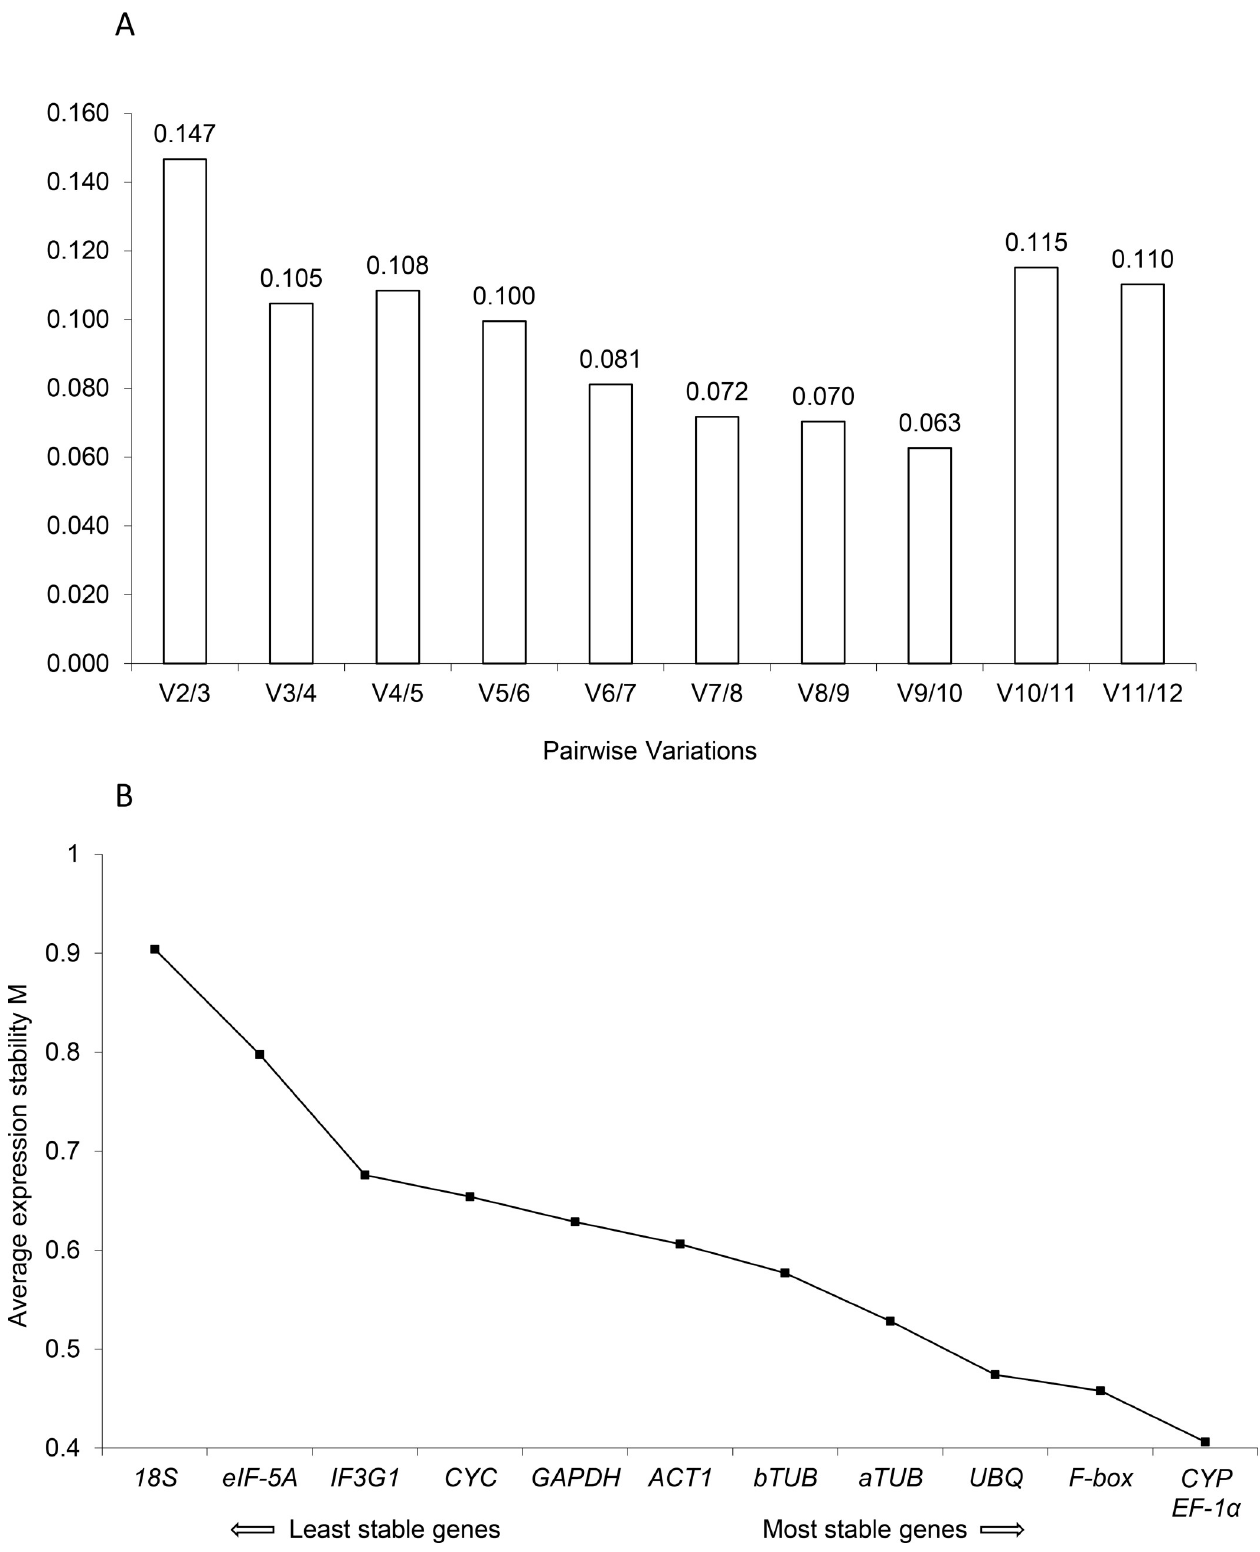
Fig 3. Stability analysis by geNorm. (A) The optimal numbers of control genes for normalization. (B) Average expression stability values of the candidate reference genes. The smaller M value indicates the better suitability of the gene for qRT-PCR normalization. https://doi.org/10.1371/journal.pone.0226168.g003 PLOS ONE | https://doi.org/10.1371/journal.pone.0226168 December5,